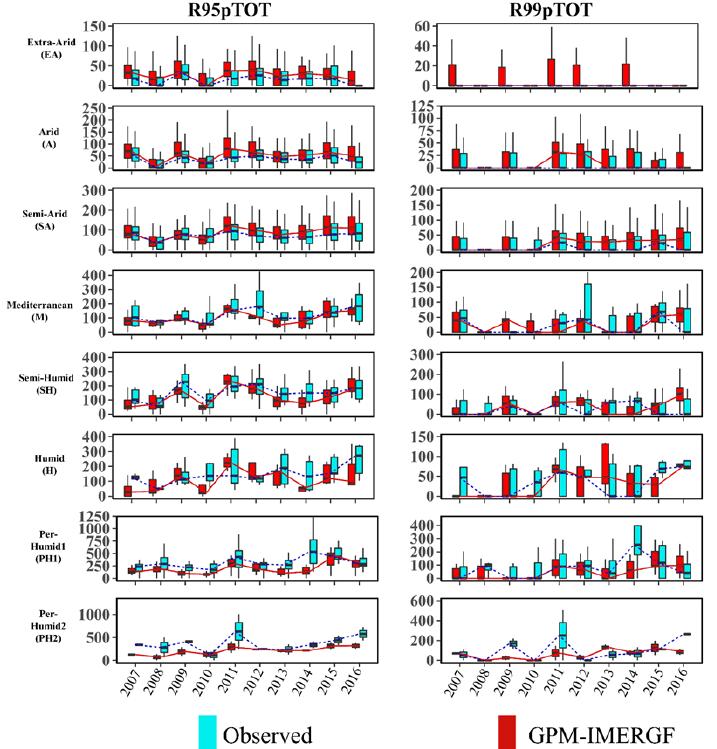
Figure 5. Temporal behavior of GPM-IMERGV6.0 Final Run (GPM-IMERGF) in capturing maximum precipitation indices beside corresponding indices based on synoptic stations throughout 2007 to